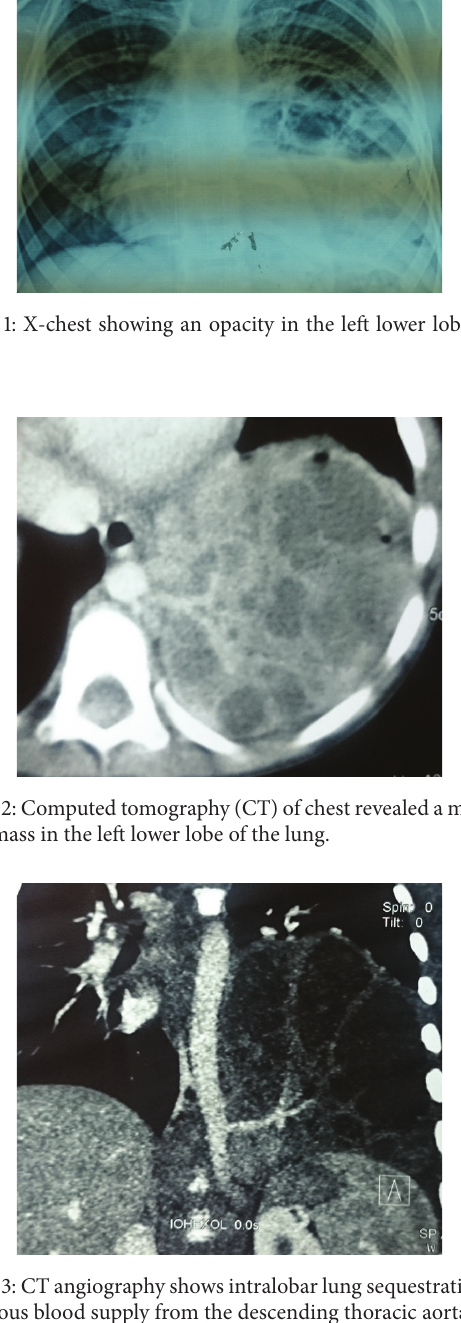
system, portal vein, right atrium, or